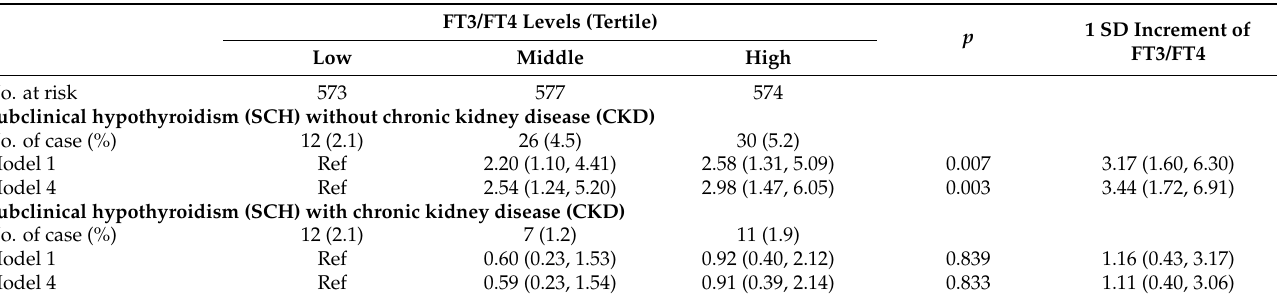
Table 4. Association between FT3/FT4, subclinical hypothyroidism (SCH) with or without chronic kidney disease (CKD). FT3/FT4 Levels (Tertile) 573